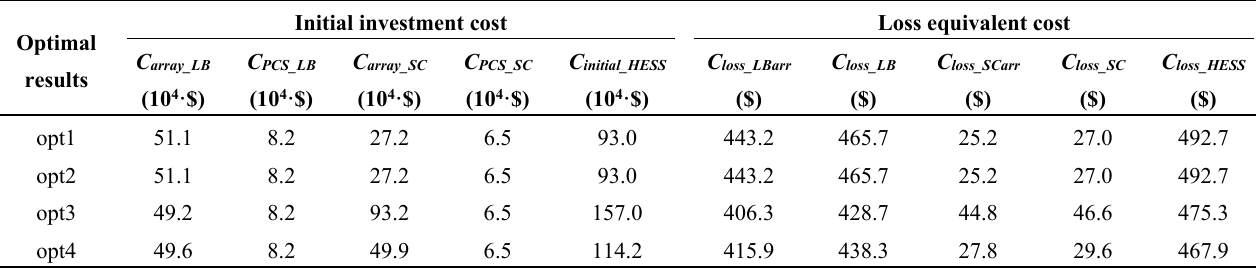
Table 4. Comparison of initial investment cost and loss equivalent cost based on optimal results.